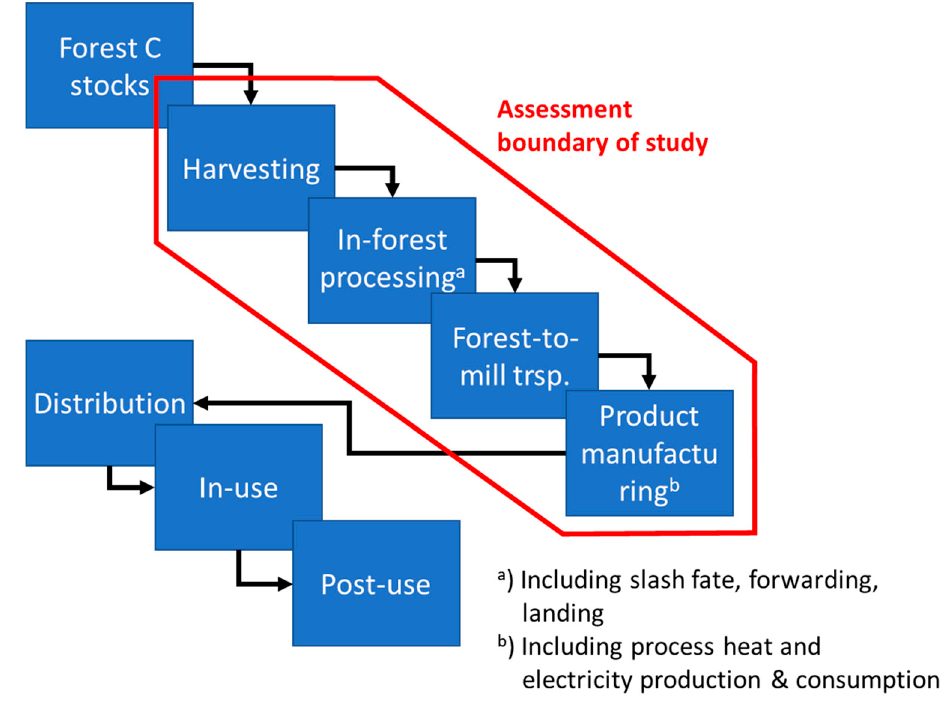
Figure 1. Carbon LCA boundary of